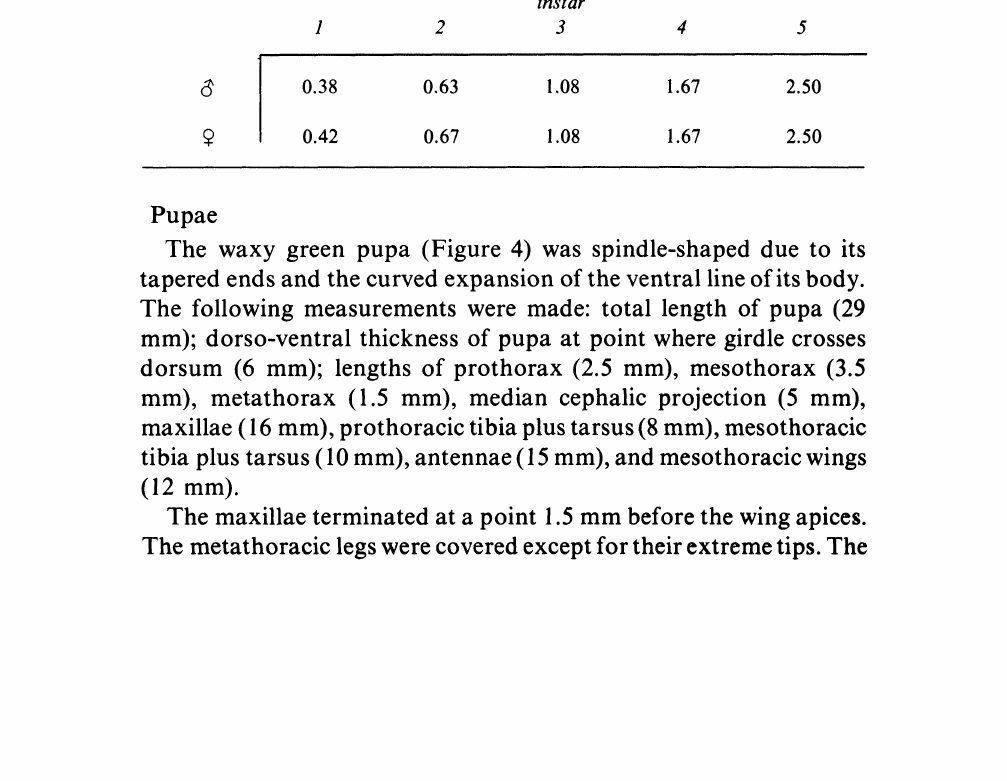
Table 1. Head capsule widths (mm) for the two reared individuals of Dismorphia amphiona beroe (Rearing lot